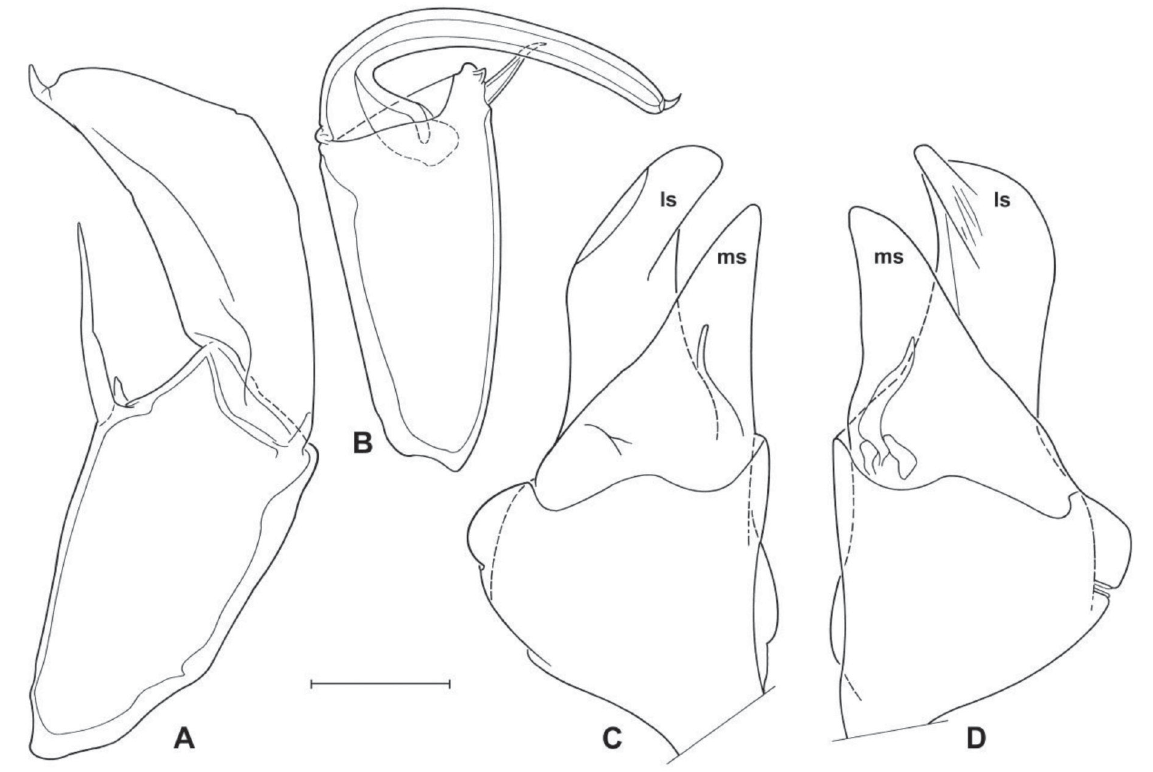
Fig. 13. Bennelongia cuensis sensu lato , all from unnamed pool near Kilcowera Station, QLD, ♂ (W40052). A . Right prehensile palp. B . Left prehensile palp. C . Hemipenis. D . Outline of other hemipenis. Scales: A-B = 89.3 μm, C-D = 104.2